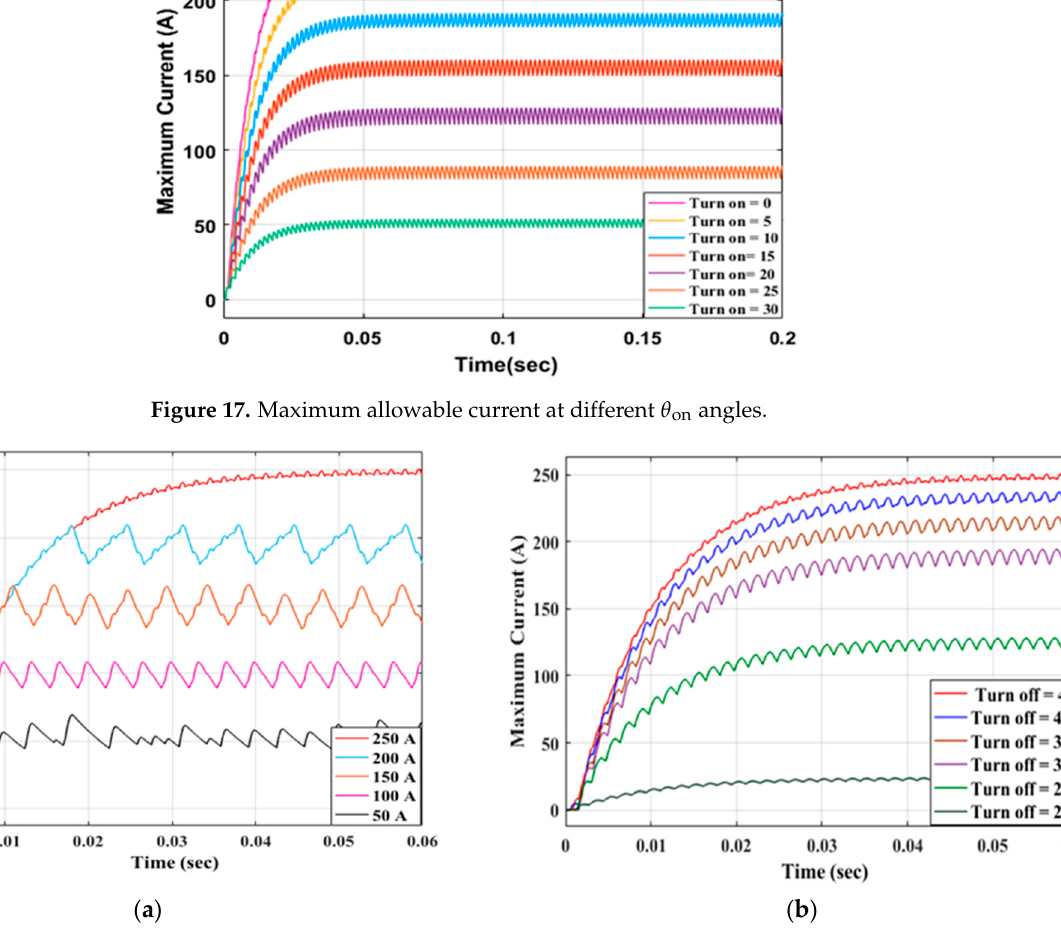
Figure 18. Constant (charging) current response for turn-on angle control, ( a ) transient current at different reference currents, and ( b ) maximum generated current at different turn-off angles.